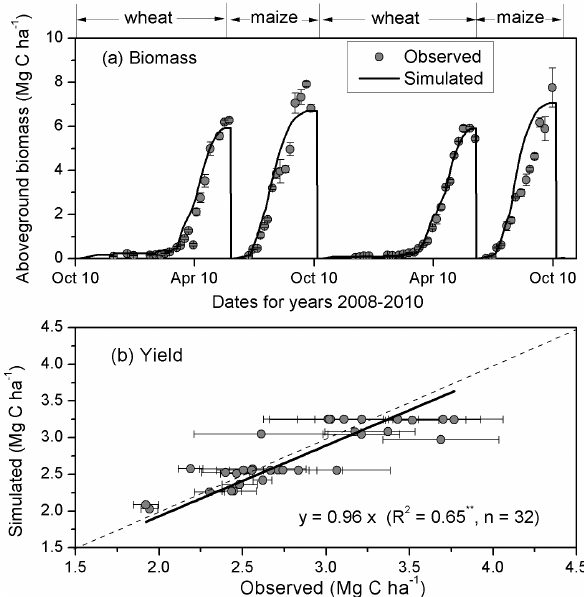
Fig. 3. Observed and simulated daily (a) and cumulative (b) net ecosystem exchange of carbon dioxide (NEE) in the wheat–maize rotation during 2009–2010. The observed data during the non-maize period were cited from Wang et al. (2013) and those during the maize growing period were unpublished data from the authors, which were measured with the eddy covariance technique as de- scribed by Wang et al.